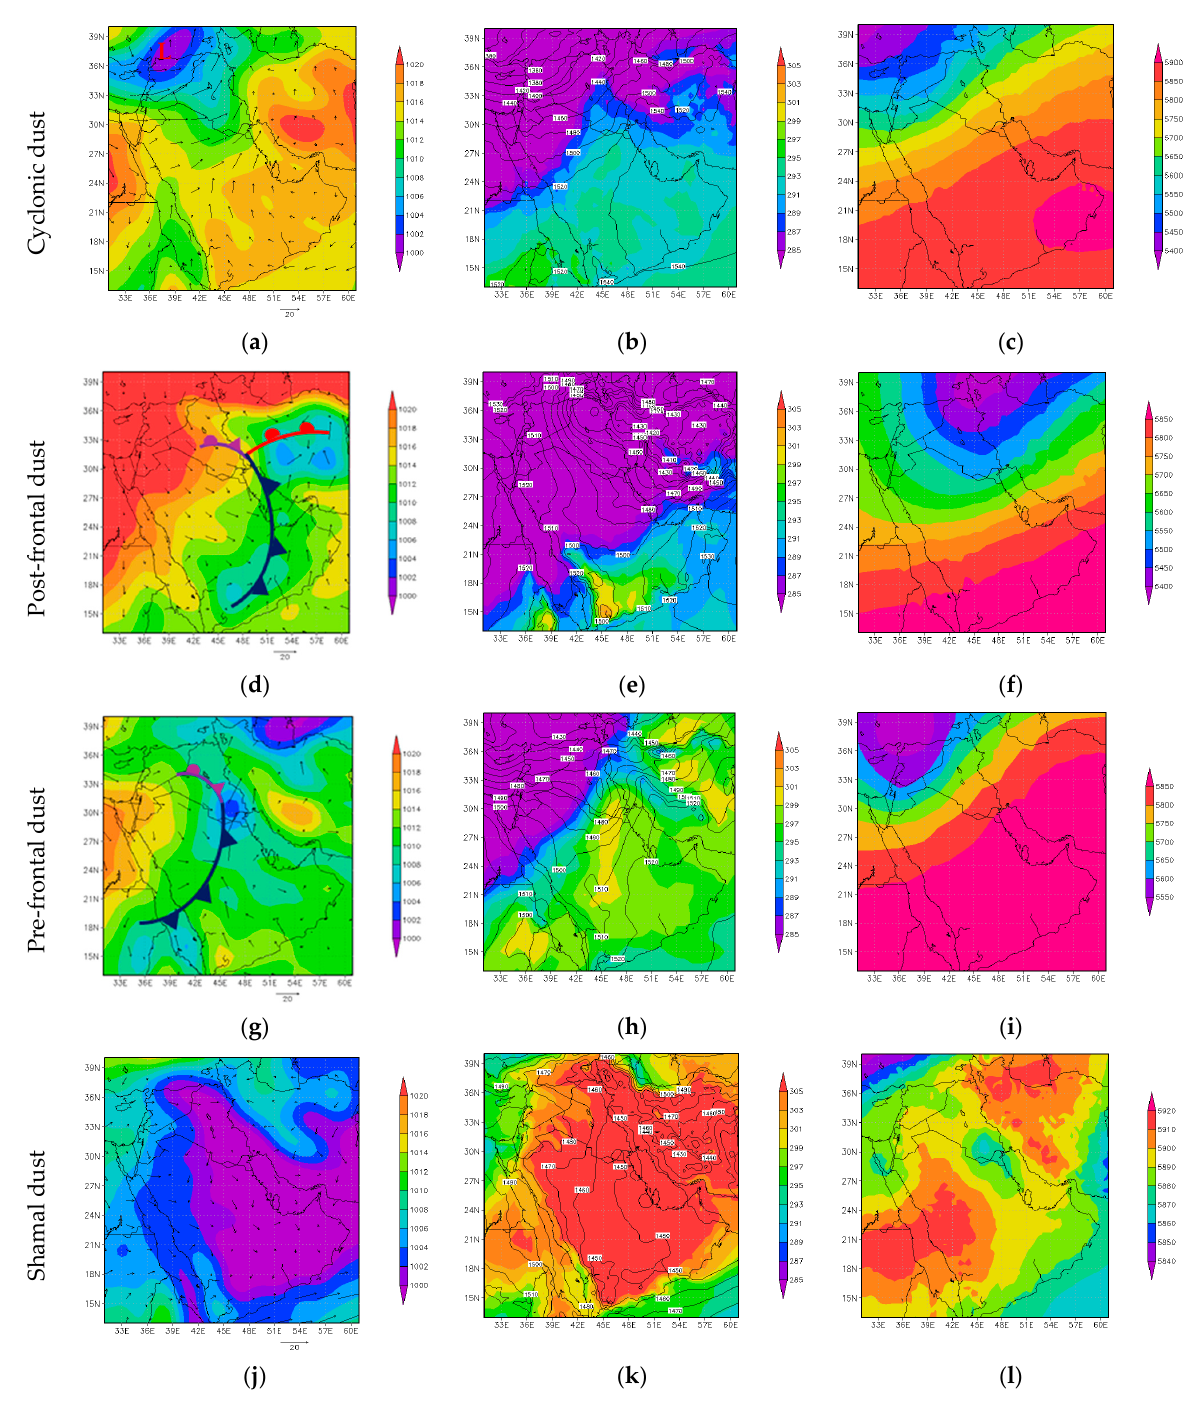
Figure 3. Mean sea level pressure (MSLP) with 10-m vector winds ( left column), geopotential height and temperature at 850 hPa level ( mid column) and geopotential height at 500 hPa ( right column) during dust storms over the Middle East on 2 December 2016 at 00 UTC ( a – c ), 17 February 2017 at 12UTC ( d – f ), 30 March 2018 at 00UTC ( g – i ), and 5 July 2017 at 12UTC ( j – l ).